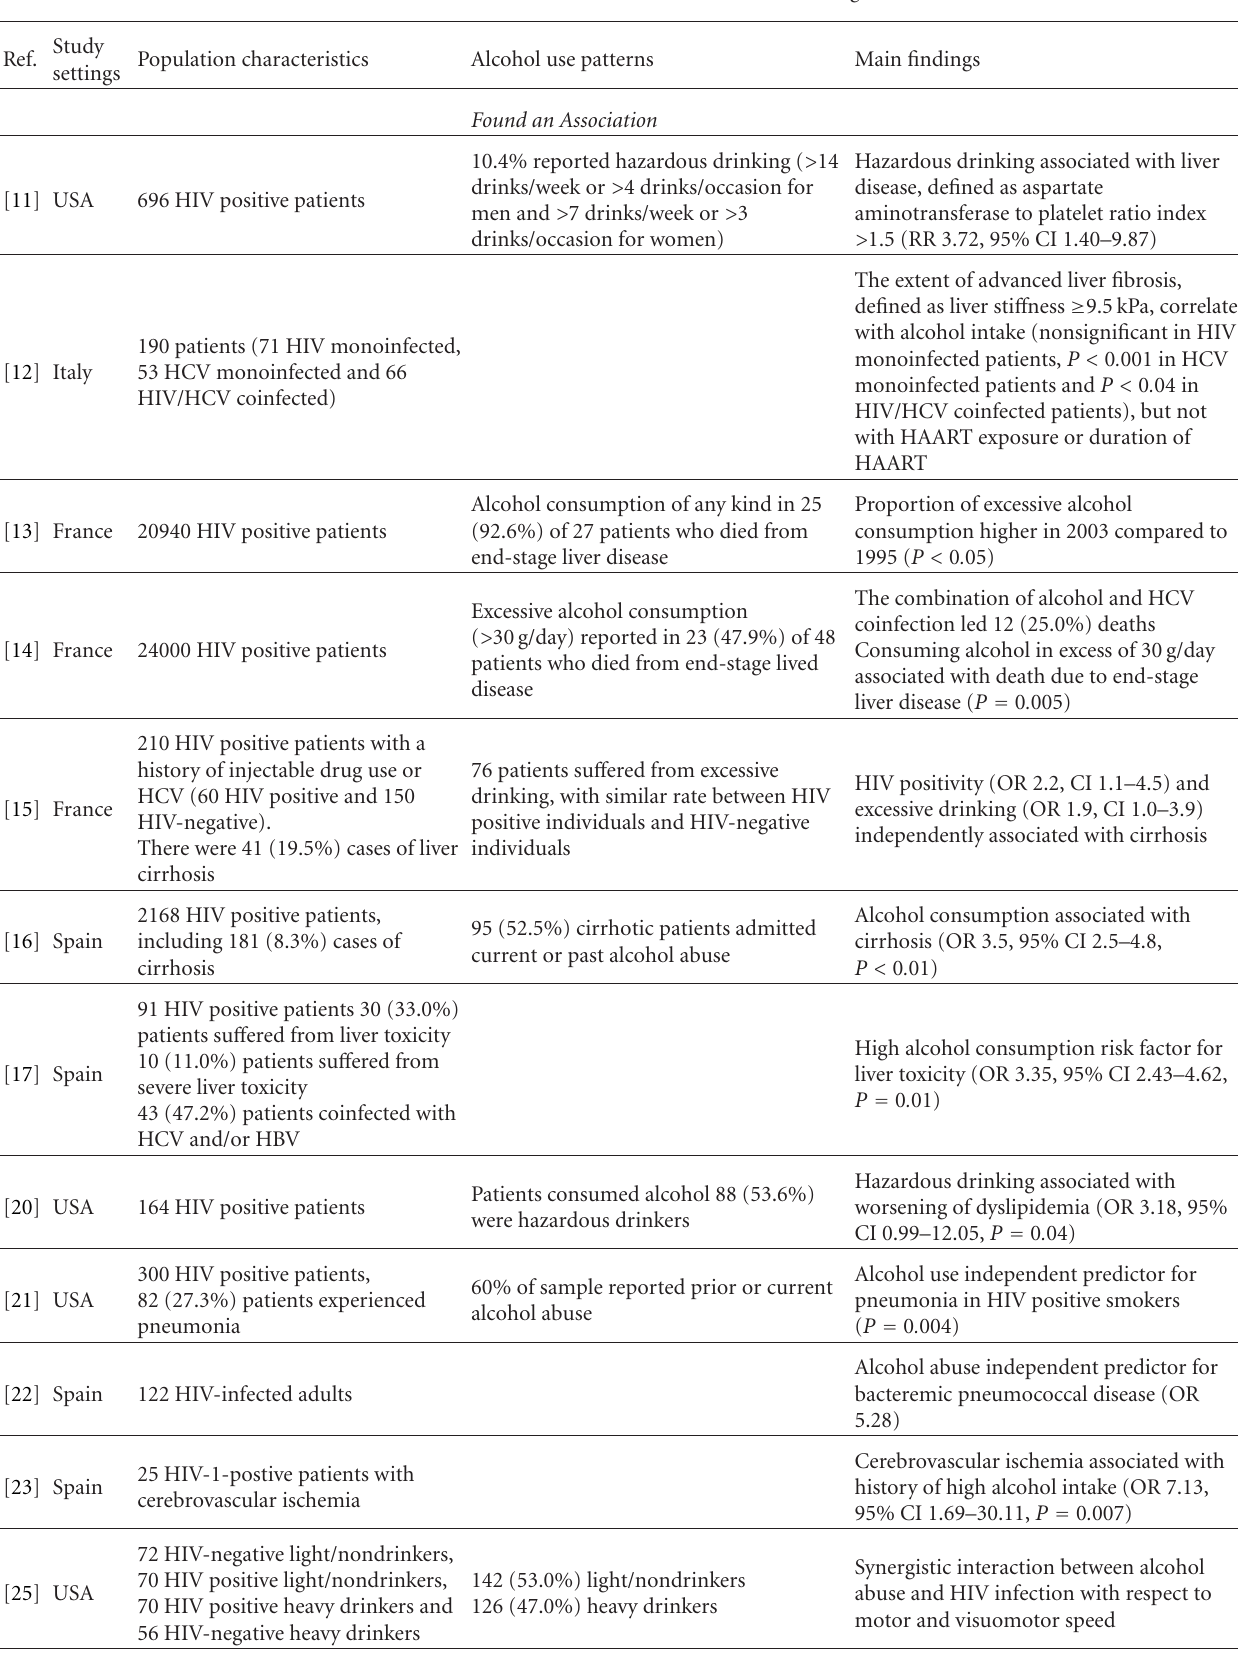
Table 1: Interactions between Alcohol and HIV Disease